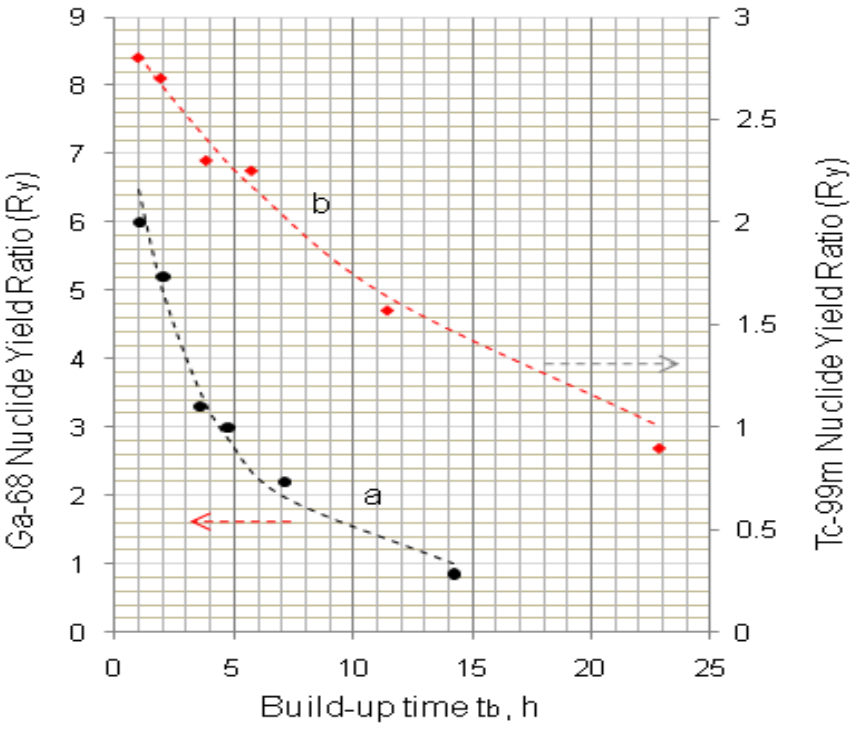
Figure 12. Effectiveness of daughter nuclide activity utilisation of generators eluted with an early elution schedule compared with that normally eluted at the maximal time of daughter nuclide build-up (Data mark-points are experimental and dashed lines are